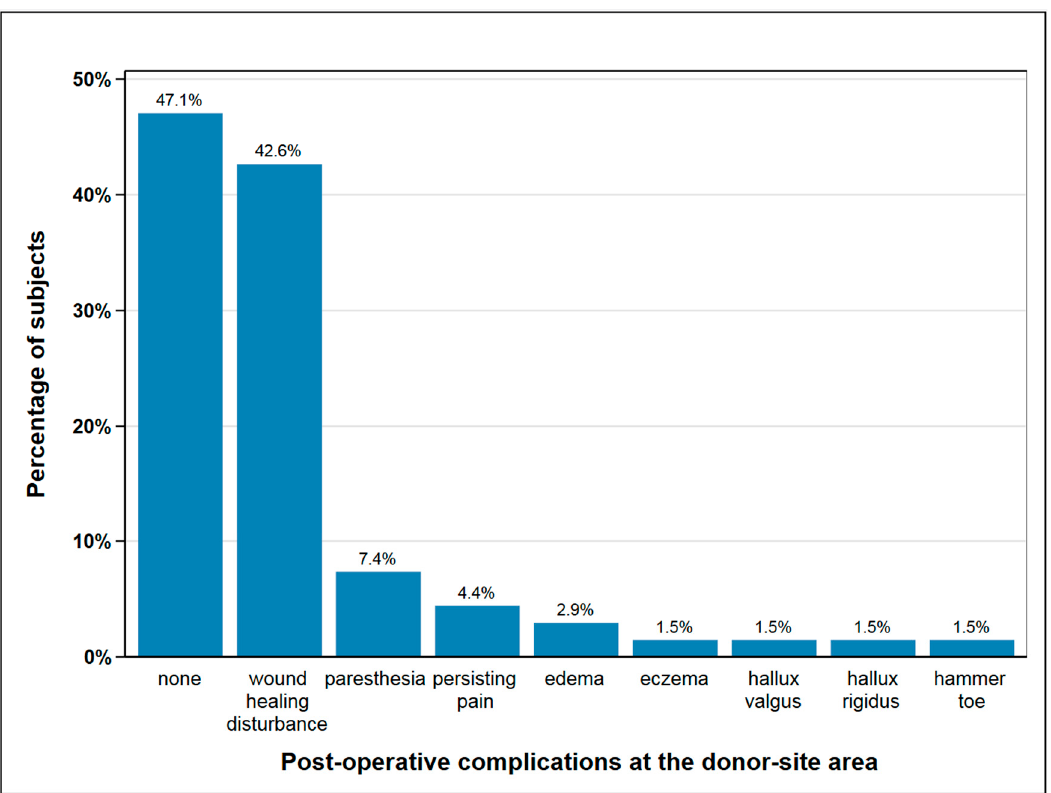
Figure 1. Post-operative complications at the donor-site area; seven subjects suffered from a second complication besides wound healing disturbance, which is paresthesia and persisting pain (each n = 2), edema, hallux rigidus and eczema (each n = 1); with seven cases of double complications this figure depicts n = 75 complications in total.